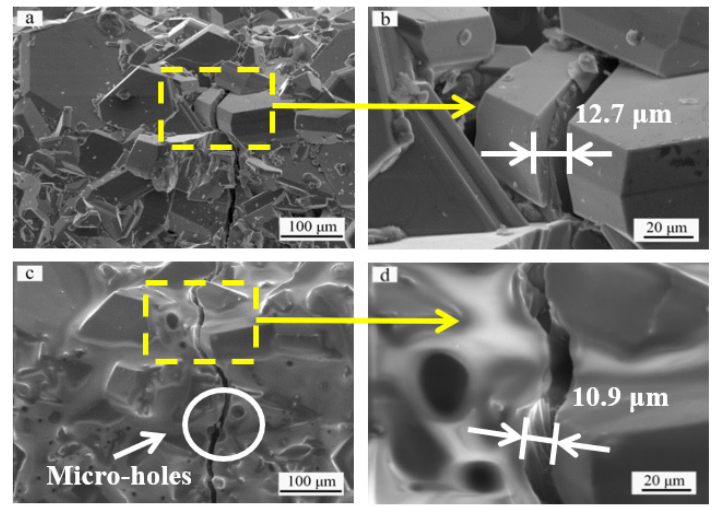
Figure 5. Surface morphologies of the SiC coating: ( a ) original surface before oxidation, ( b ) magnified image of the selected area in ( a ) showing a typical crack with 12.7 μ m in width, ( c ) top view of the same area in ( a ) after oxidation, ( d ) magnified image of the selected area in ( c ) showing the healing of the crack.